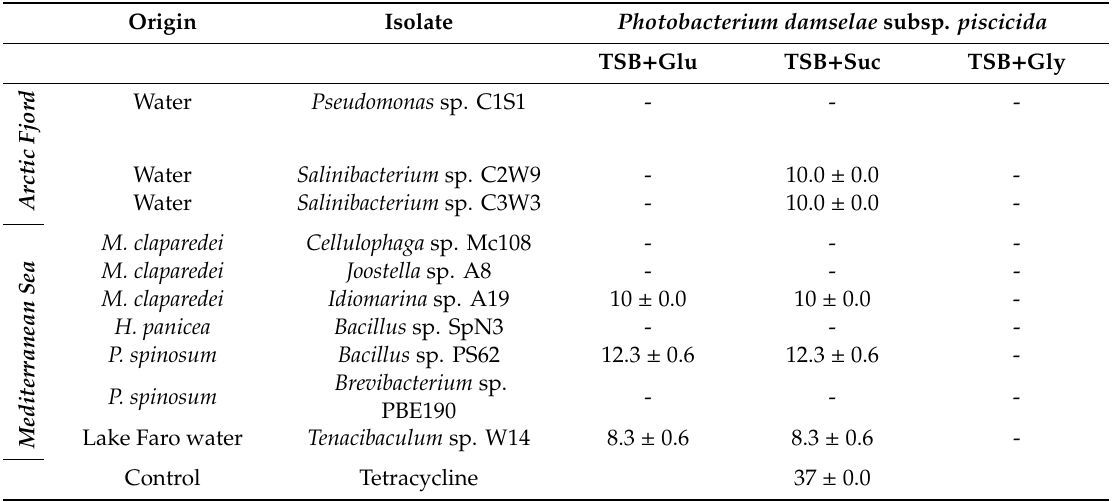
Table 3. Inhibitory activity exhibited by concentrated supernatants (CFSc) of selected